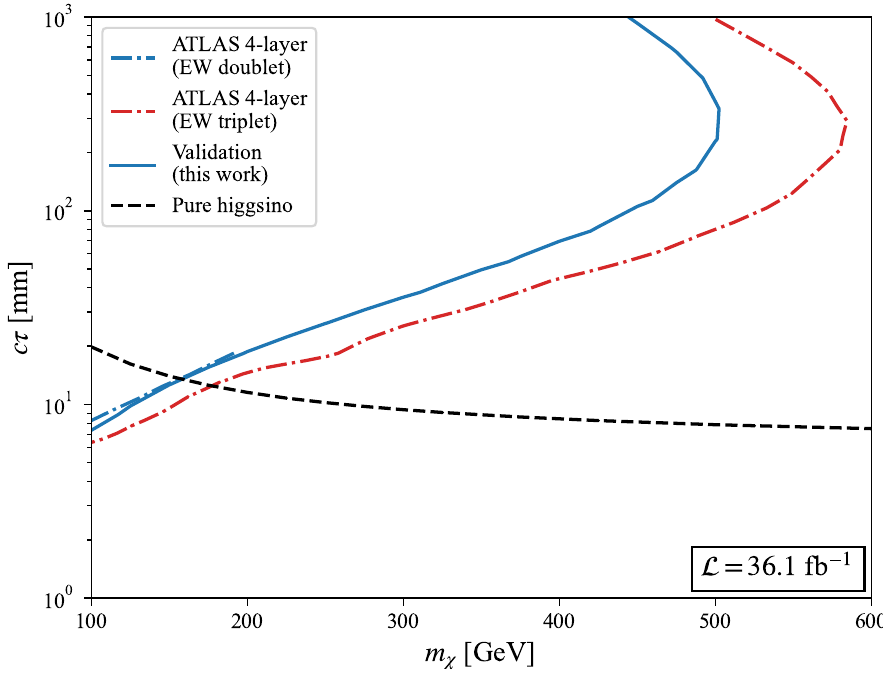
Figure 5 . The solid blue curve shows our reproduction of the ATLAS exclusion region for the EW doublet (dot-dashed blue curve) using the analysis from ref. [13] with an integrated luminosity of 36.1 fb − 1 . The corresponding ATLAS limit for the EW triplet (dot-dashed red curve) is shown for